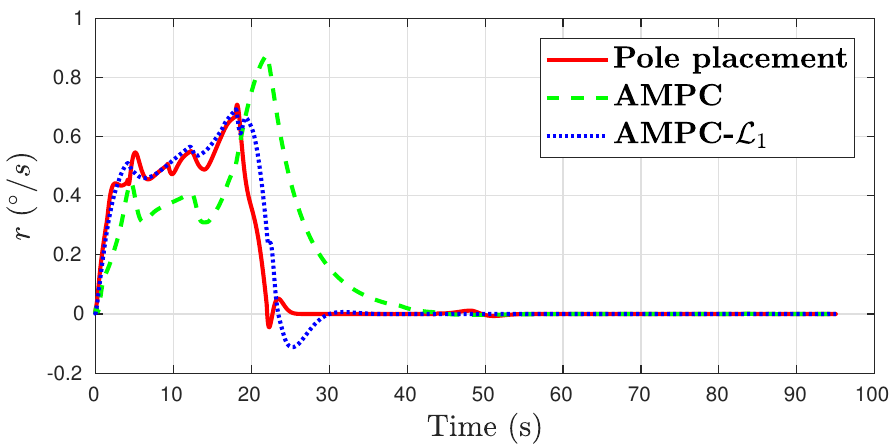
Figure 10. Yaw rate regulation error for aerodynamic uncertainty case.